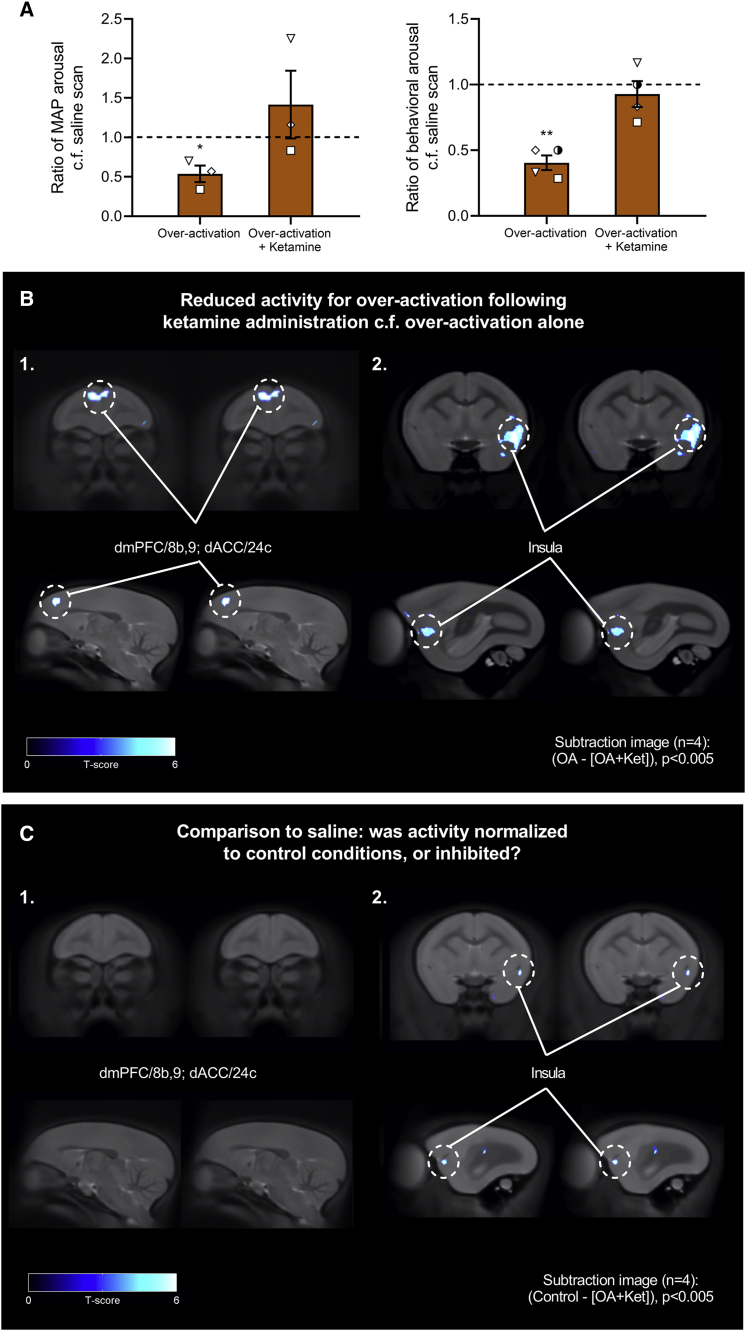
Reversal of Blunted Anticipatory Arousal by Ketamine Is Associated with Metabolic Changes within dmPFC, dACC, Insula, and sgACC/25Relevant graphs show mean ± SEM (n = 3 for cardiovascular arousal; n = 4 for behavioral arousal). n = 4 for all PET images; clusters discussed are significant at the level of p < 0.005 with an extent threshold adjusted for search volume of 26 voxels.(A) Ketamine administration 1 day earlier ameliorated the blunted cardiovascular arousal associated with over-activation alone, returning cardiovascular arousal to levels no different from the saline scan (one-sample t test on ratio values compared to 1.0, over-activation alone, p = 0.048; over-activation + ketamine, p = 0.435). Ketamine administration also ameliorated the blunted behavioral arousal associated with over-activation alone, returning behavioral arousal to levels no different from the saline scan (one-sample t test on ratio values compared to 1.0, over-activation alone, p = 0.007; over-activation + ketamine, p = 0.435).(B) Subtraction images calculated from SUVR maps for over-activation (OA) scans—[over-activation + ketamine (Ket)] scans, showing brain regions with reduced activation following ketamine administration 1 day earlier. Reversal of blunted anticipatory arousal was associated with reduced activity in dmPFC/8b,9, dACC/24c (1) and left ventral insula (2).(C) Subtraction images calculated from SUVR maps for control scans—[over-activation + ketamine] scans revealed that activity in the dmPFC/8b,9 and dACC/24c region was no different from control scans, indicating that ketamine had normalized over-activity in these regions to control levels (1). However, activity in the left insula was reduced even compared to control conditions, suggesting that ketamine administration caused deactivation of the insula (2).